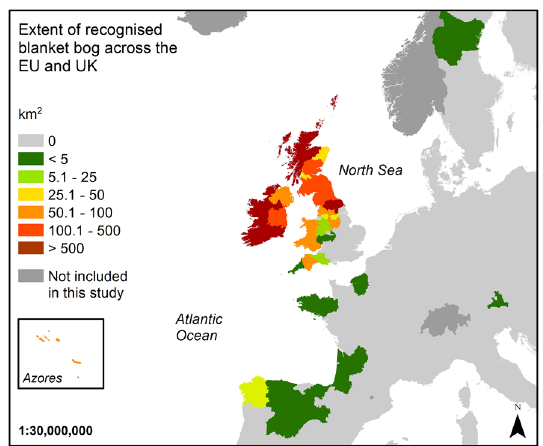
Figure 1. Total extent of the recognised blanket bog by European regions NUTS level 2 based on the Habitats Directive (92/43/EEC) including the last update from the UK before Brexit. Map created in ArcGIS